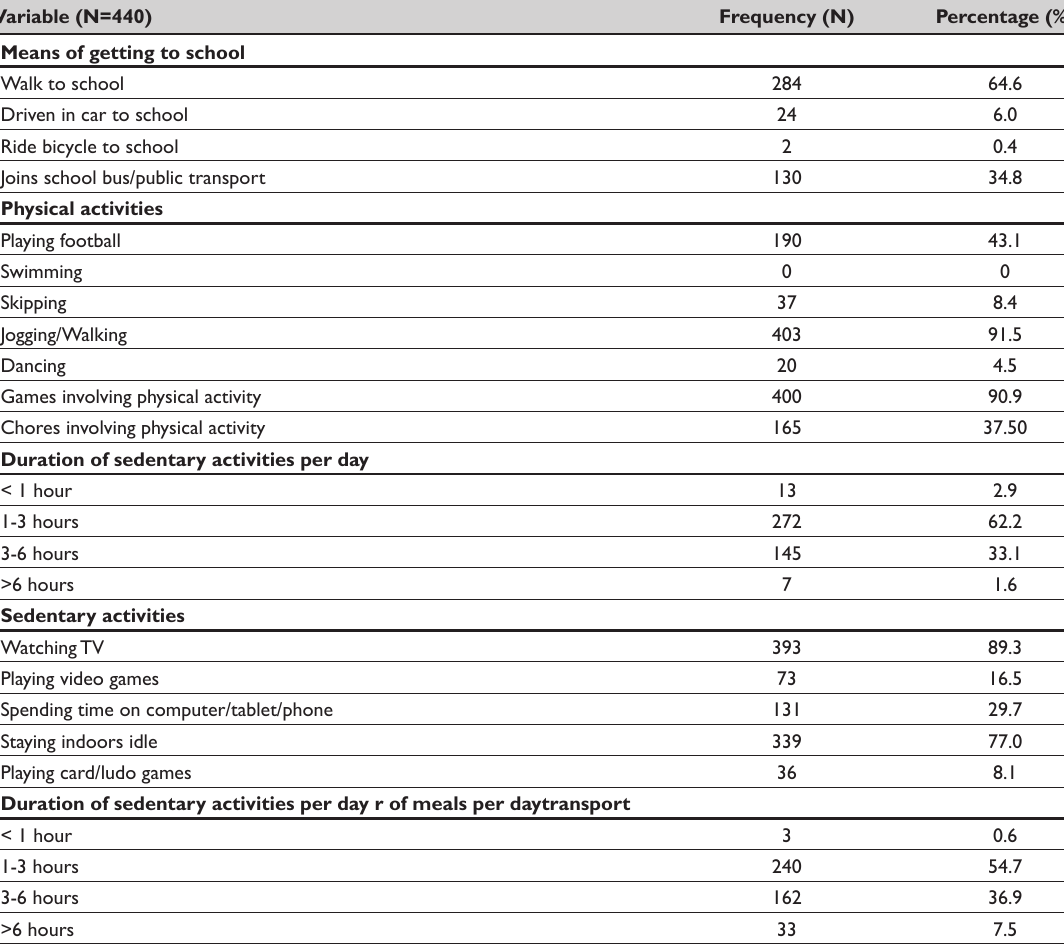
Table 2: Physical activities and sedentary activities of the school-aged children Variable (N=440)